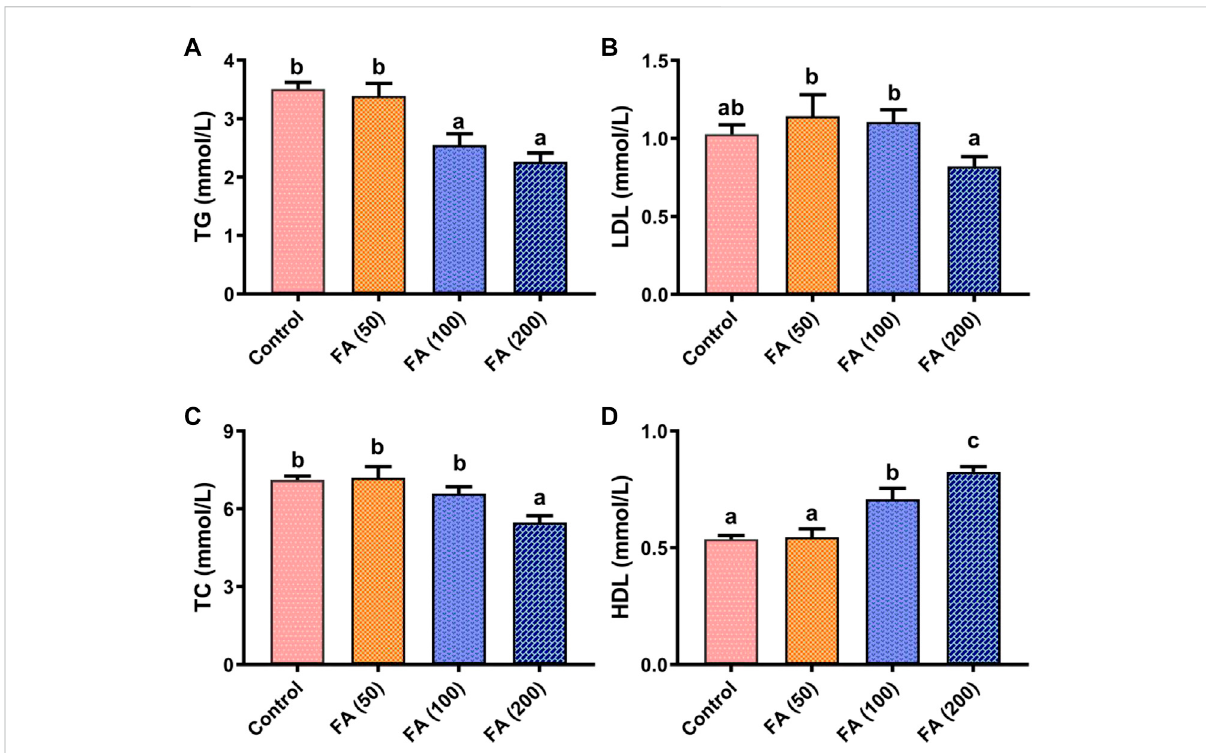
FIGURE 3 Blood biochemical parameters including triglyceride (TG; (A) , low-density lipoprotein (LDL; (B) , total cholesterol (TC; (C) , and high-density lipoprotein (HDL; (D) in grass carp fed CSM-based diets containing graded levels of ferulic acid. Control: high CSM diet; FA (50): high CSM diet +50 mg/kg ferulicacid; FA (100): high CSM diet+100 mg/kg ferulicacid; FA (200):highCSM diet +200 mg/kg ferulic acid.The results are expressed as means ± standard error of the means ( n = 9). Means of the same parameter with different superscripts are signi fi cantly different ( p < 0.05).